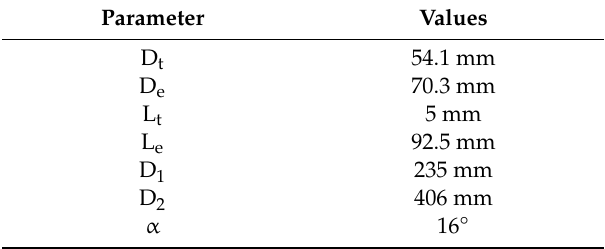
Table 1. Geometry of the lance